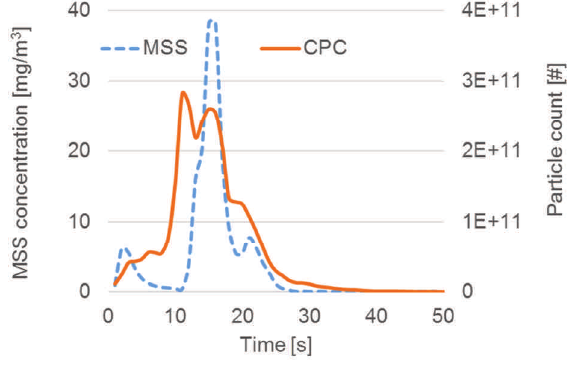
Fig. 11. CPC (solid particles only) and MSS readings over the first 50 seconds of the WLTP, for vehicle 3 Focusing on the first 50 seconds of the two cycles,